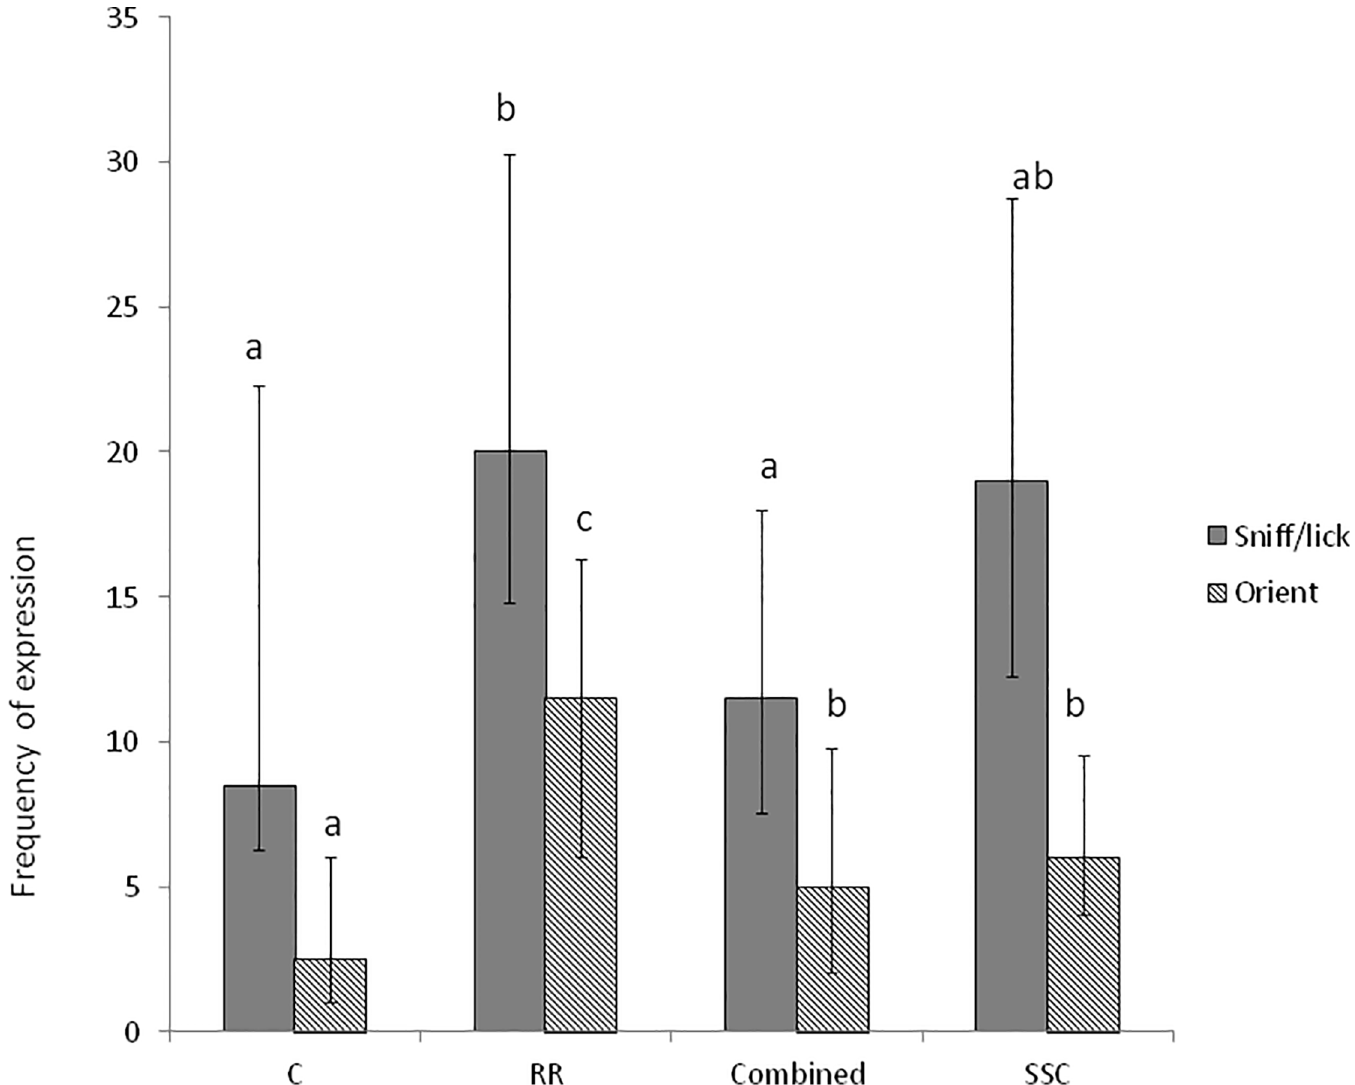
Fig 2. Maternal licking and sniffing behavioural responses. Median frequency (with upper and lower quartile ranges) of maternal sniffing/licking behaviour (solid bars) and orientation (hatched bars) towards her treated lamb (n = 80) by ewes for the 30 minutes following handling (C), castration with rubber rings (RR), castration with tight rubber rings followed by Burdizzo (Combined) or short scrotum castration (SSC) of her lamb. Differences between treatments (within a behaviour) are indicated by different letters.